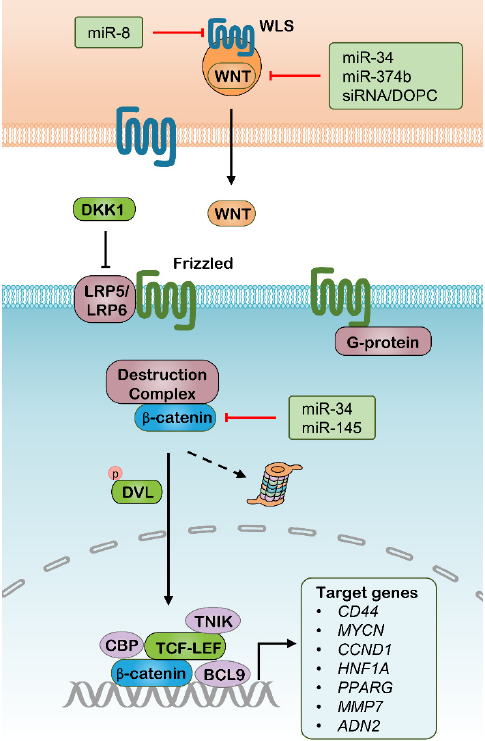
Figure 1. The canonical Wnt signaling pathway and potential RNAi targets. WLS, WNT ligand secretion mediator; DKK1, Dickkopf–related protein 1; LRP, Lipoprotein receptor–related protein; DVL, Disheveled Segment Polarity Protein; CBP, Cyclic AMP response element–binding protein; TNIK, TRAF2 And NCK Interacting Kinase; TCF, T cell–specific transcription factor; LEF, Lymphoid enhancer–binding factor; BCL9, B–Cell Lymphoma 9